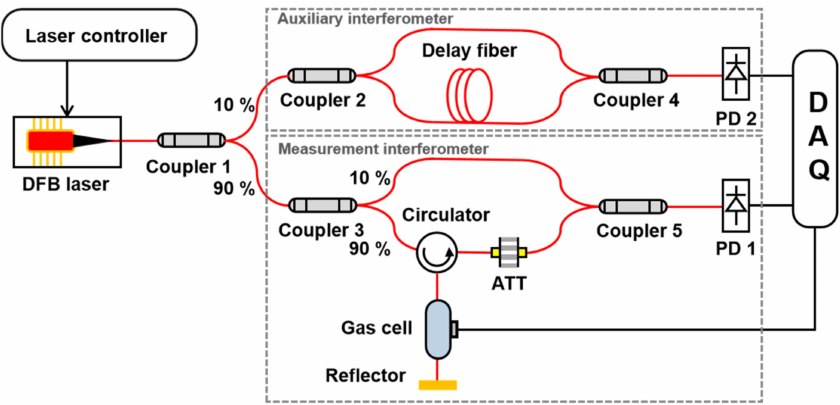
Figure 3. Experimental setup of the all-fiber PAS system with interferometric location. DFB laser, distributed feedback laser; Coupler 1 and Coupler 3, 90:10; Coupler 2, Coupler 4, and Coupler 5, 50:50; ATT, optical attenuator; PD, photodetector; DAQ, data acquisition